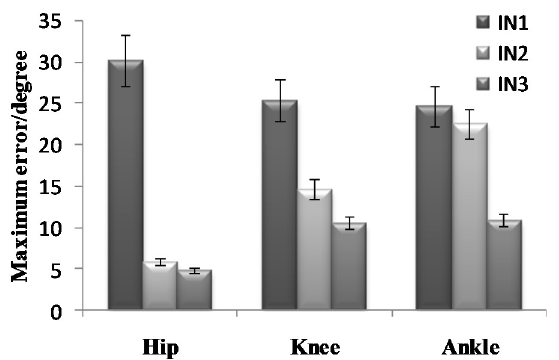
Figure 19. Maximum error of the prediction results in the going upstairs process.